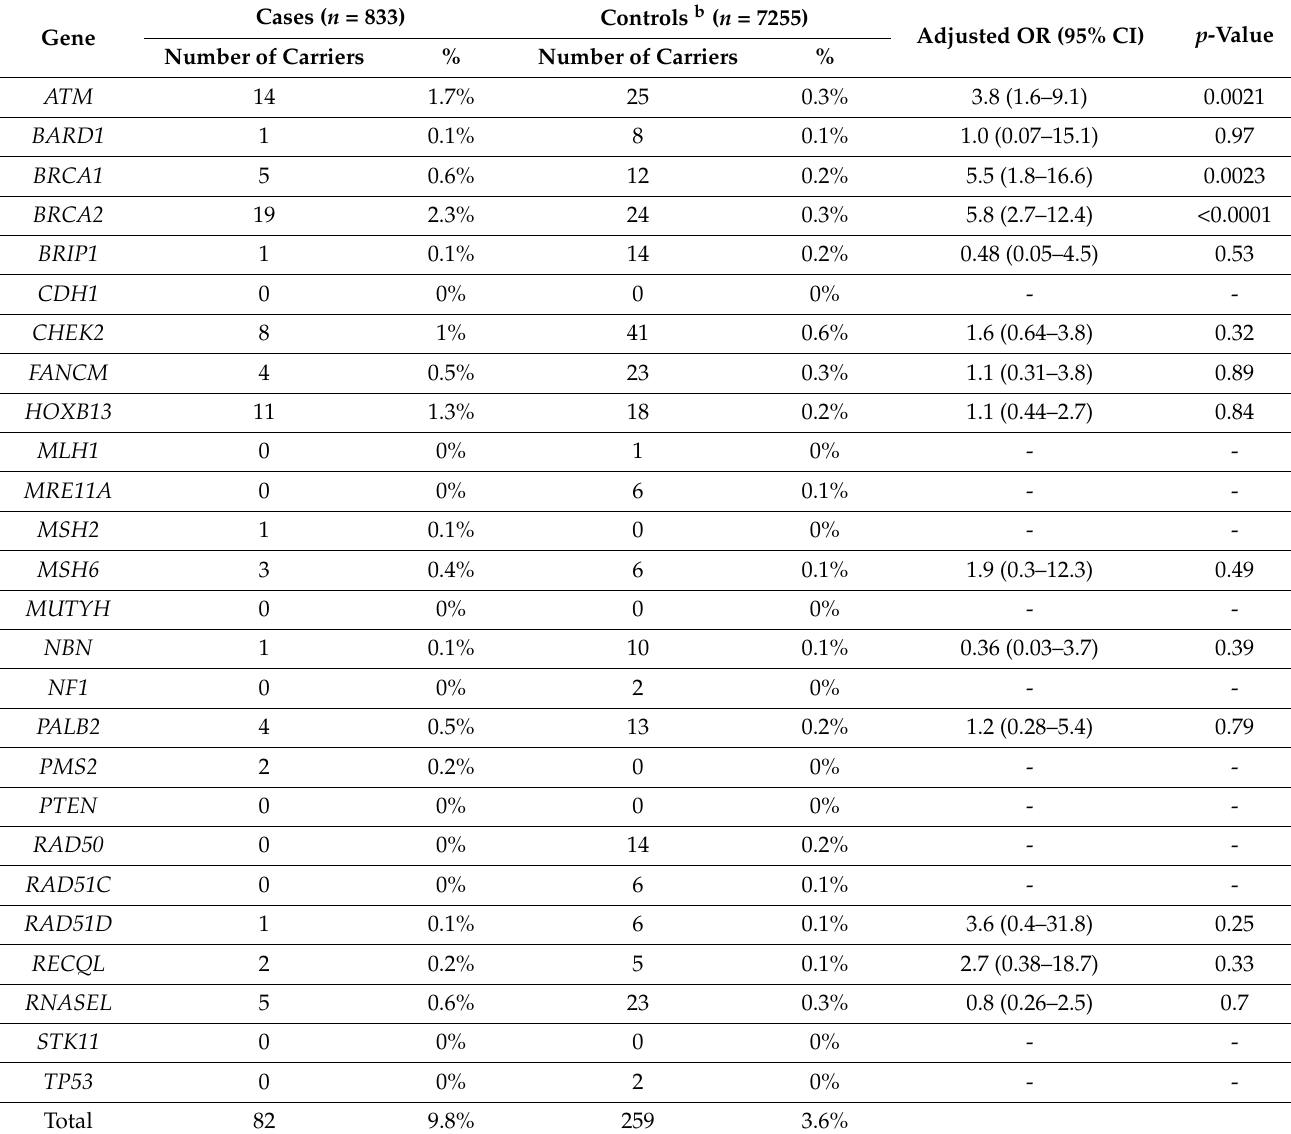
a Pathogenic (including likely pathogenic) as defined by ClinVar and protein-truncating variants that are absent from ClinVar (accessed November 2020). Excludes protein-truncating variants located in the last coding exon and mono-allelic MUTYH pathogenic variants. For PMS2 , panel design avoided regions of homology with the pseudo-gene PMS2CL (as described previously [17]). b Men without aggressive prostate